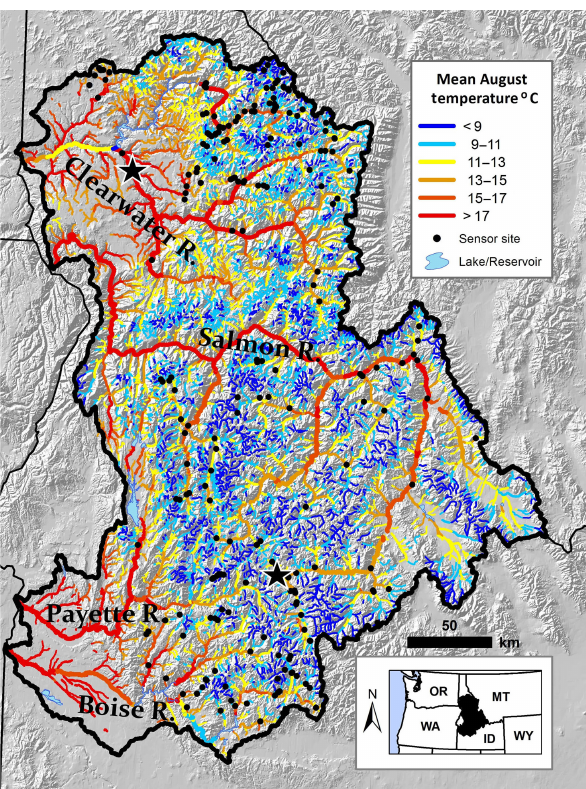
Figure 1. Locations of 226 monitoring sites overlaid on an August stream temperature scenario for the 29600km network in the study area. Stars denote where air temperature and stream discharge data were obtained from a low-elevation site (294m, northern station) and a high-elevation site (1850m, southern station).